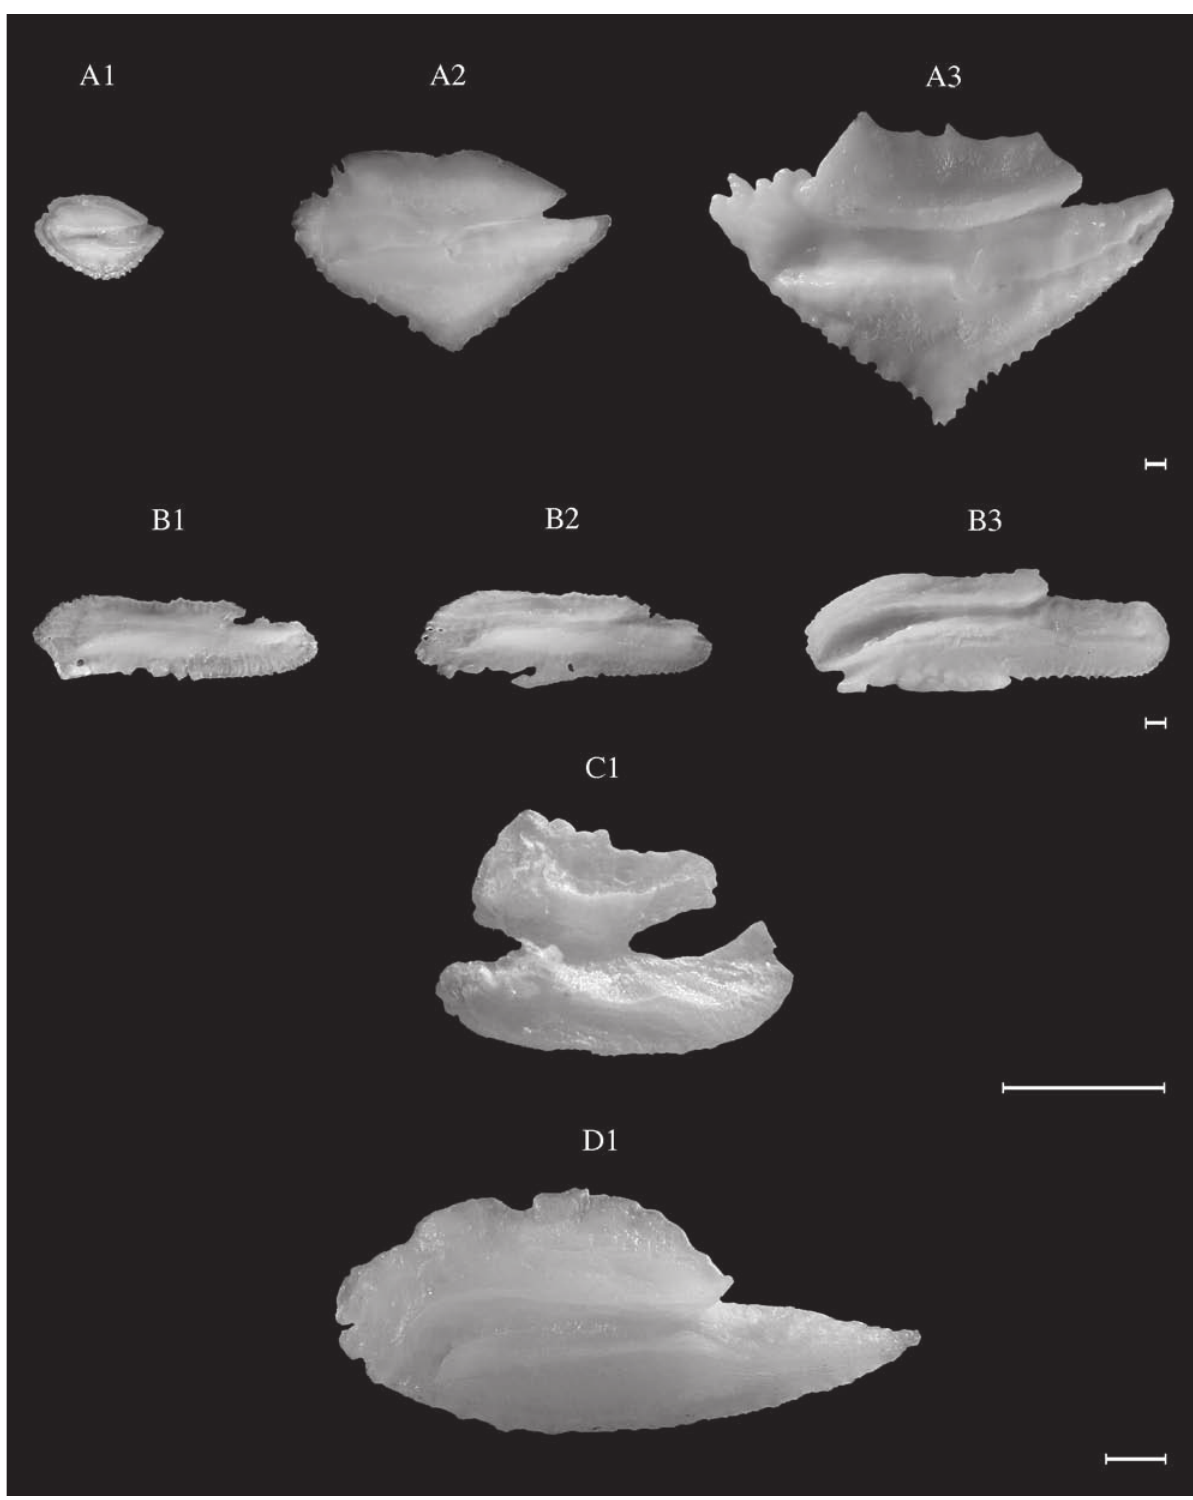
Fig. 51. – Epigonus telescopus . TL: A1, 13.0 cm (WM); A2, 37.6 cm (NEA); A3, 69.0 cm (CEA). Pomatomus saltarix (CEA). TL: B1, 51.0 cm; B2, 67.3 cm; B3, 80.0 cm. Coryphaena hippurus (WM). TL: C1, no available data. Caranx rhonchus (NEA). TL: D1, 38.0 cm. Scale bar = 1